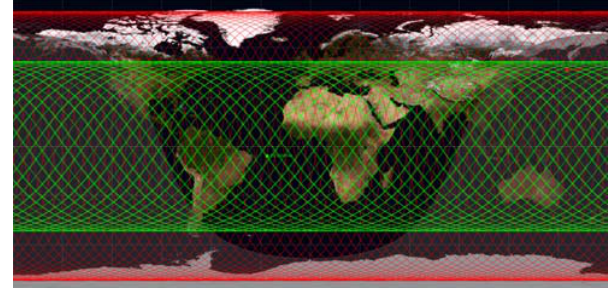
Figure 1. DESIS (green) and EnMAP (red) orbits for four day